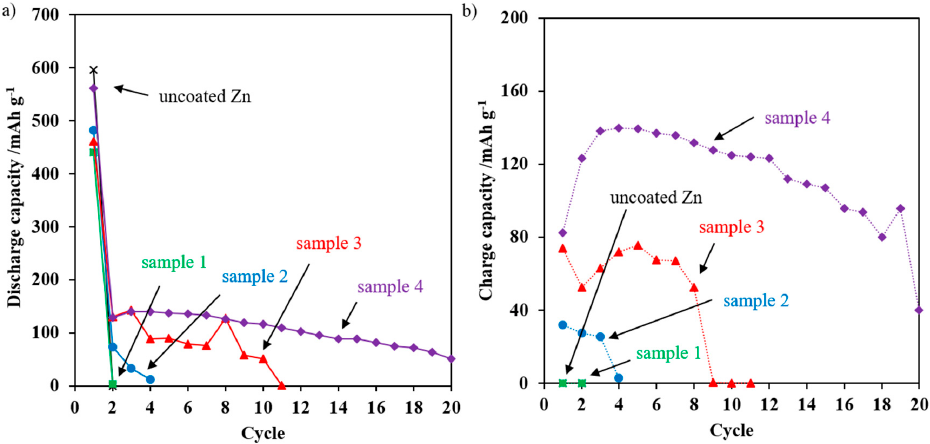
Figure 5. ( a ) Discharge capacities and ( b ) charge capacities of uncoated, coated 250 µ m and 30 µ m zinc particles plotted over the number of cycles. Table 3. Internal resistances of electrochemically investigated zinc–glass composites before the first discharge, after the first discharge, and after the first